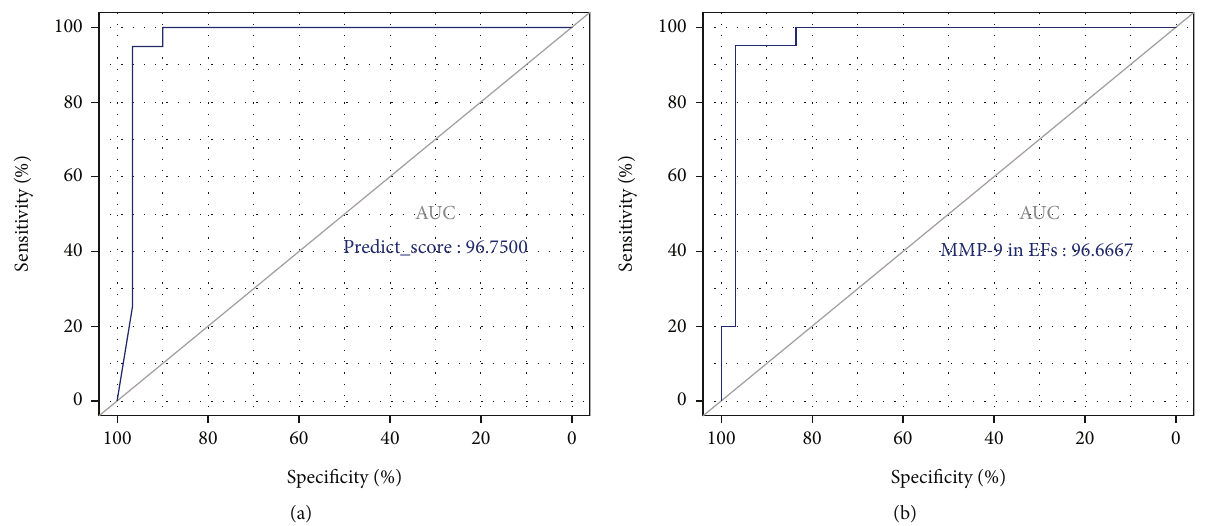
Figure 5: ROC curves of predictive model and variable MMP-9 in elastic fi bers. (a) The RF predictive model based on 5 variables as sex, age, deepness of granulomatous in fi ltration, MMP-9 IOD/area in elastic fi bers, and pSTAT1 IOD/area in the nuclei of histiocytes showed an AUC of 0.9675. (b) MMP-9 in elastic fi bers obtained an AUC of